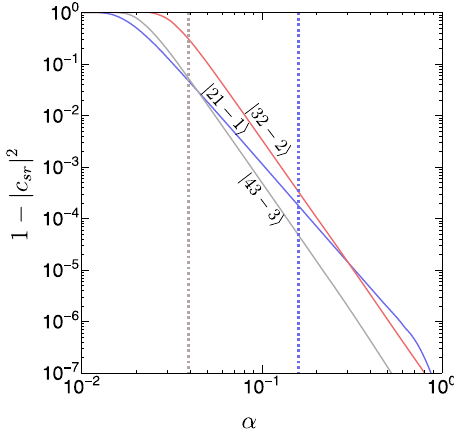
Fig. 8 | Landau-Zener transitions. Colored lines: probability of resonant Landau- Zener transitions induced by EMRIs from the superradiant level ∣ 211 i to selected decayinglevels.Transitionprobabilitiesto ∣ 21 (cid:3) 1 i , ∣ 32 (cid:3) 2 i ,and ∣ 43 (cid:3) 3 i areshown inblue,red,andgray,respectively.Dashed-coloredverticallines:minimumvalueof the gravitational coupling required for the EMRI to scan the corresponding reso-